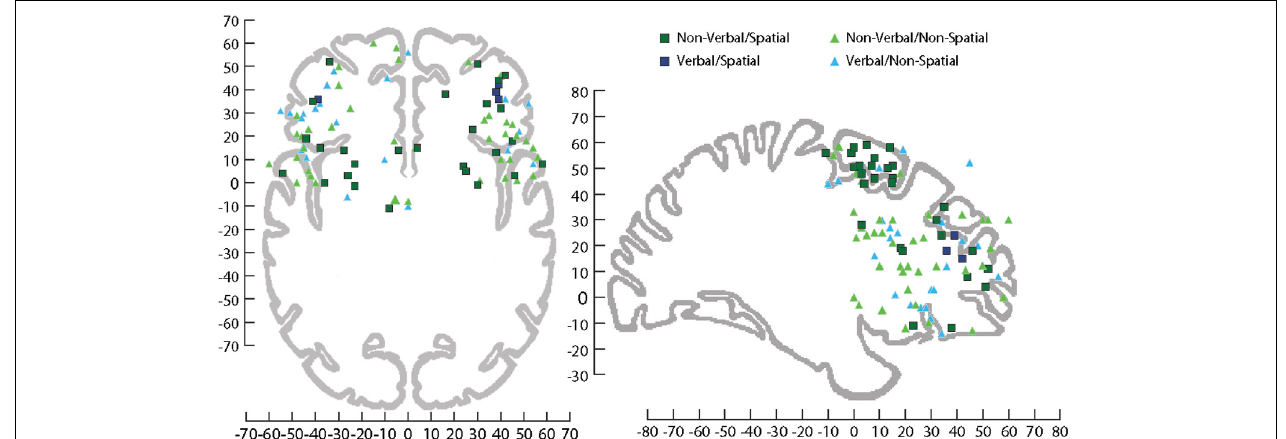
FIGURE 6 | Sagittal and horizontal view of human brain on which activations have been plotted across several fMRI studies involving processing of information during tasks that utilized stimuli that were Non-verbal/Spatial (dark green square), Non-verbal/Non-spatial (light green triangle), Verbal/Spatial (dark